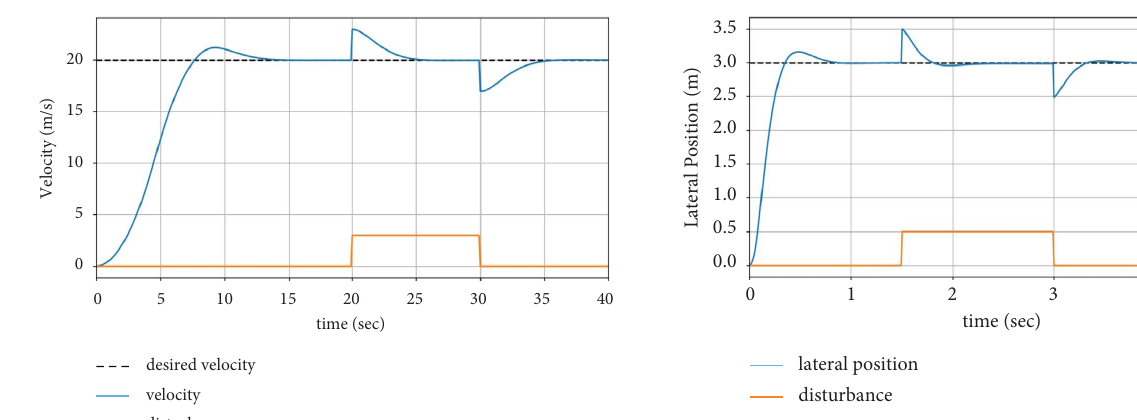
Figure 9: Tracking desired lateral position in the presence of external